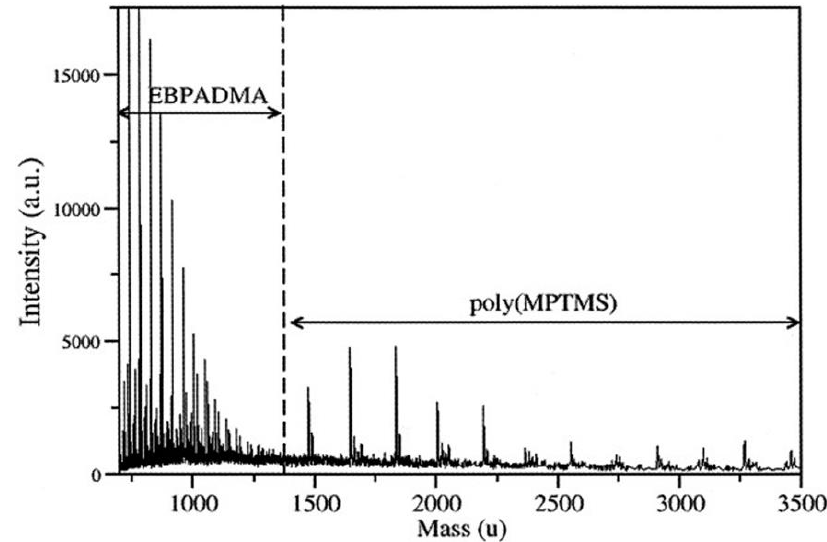
Figure 24. The mass spectrum of the polymerization of MPTMS with dental monomer (ethoxylated bis-phenol A dimethacrylate (EBPADMA)). Reprinted with permission from [94]. Copyright John Wiley and Sons, 2005.